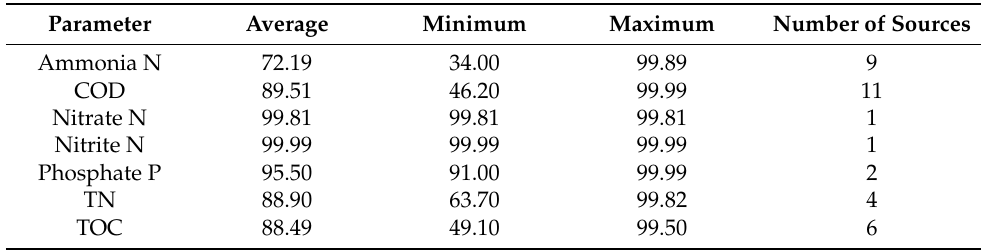
Table 2. Average, minimum, and maximum rejections recorded for MD systems for common wastew- ater quality parameters with the number of sources for each